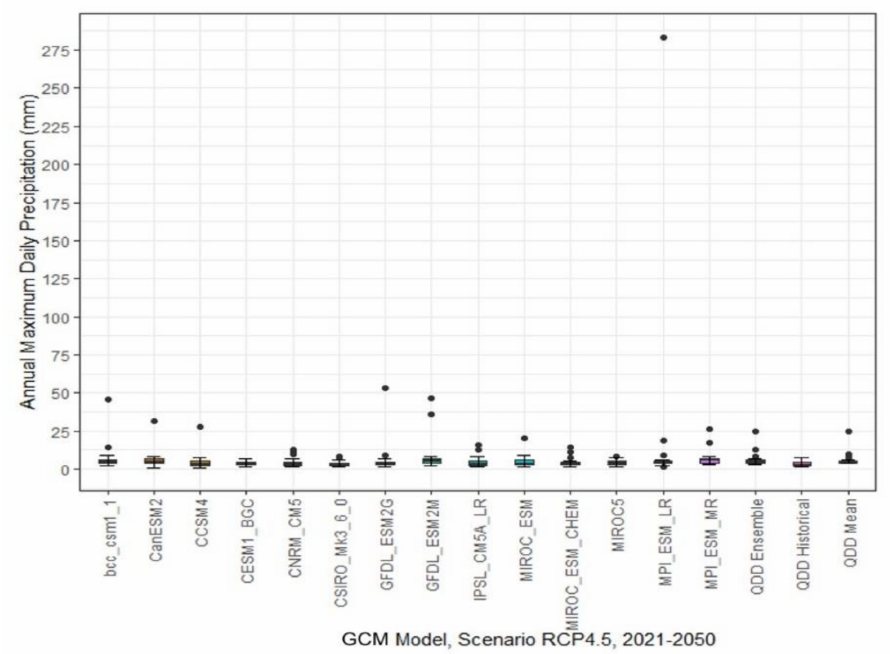
Figure 13. Boxplot for future projections of the annual maximum daily precipitation of 14 GCMs under the RCP4.5 scenario in the Devil’s Creek, period 2021–2050. The linear extensions represent the highest and lowest values; the upper, middle and lower limits of the box represent the percentiles of 75%, 50%, and 25%, respectively; and the solid circles represent the